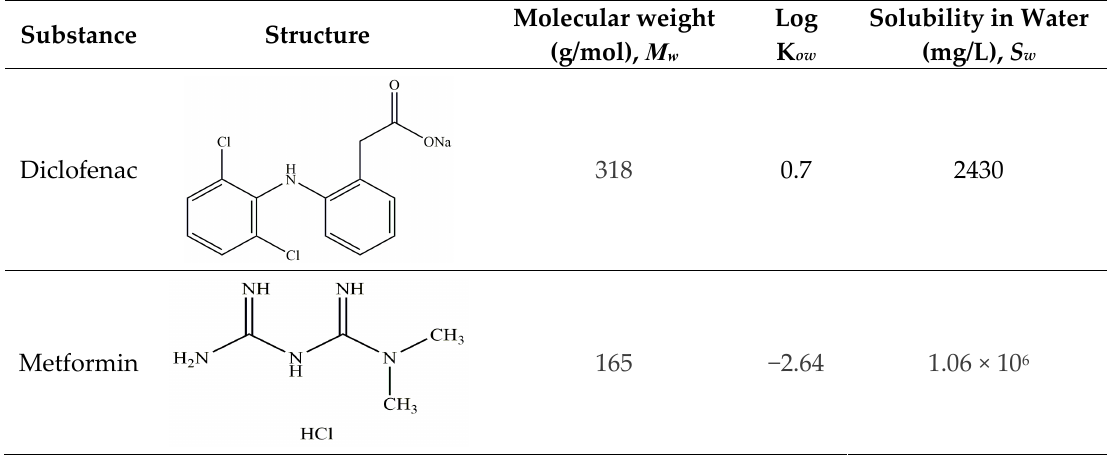
Table 1. Physico-chemical characteristics of diclofenac and metformin